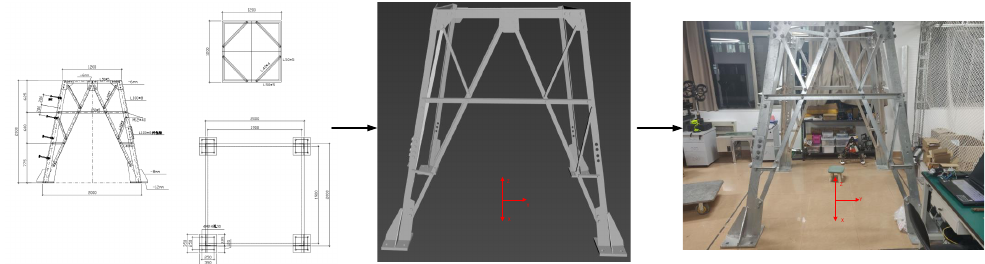
Figure 13. Transmission tower experimental environment.